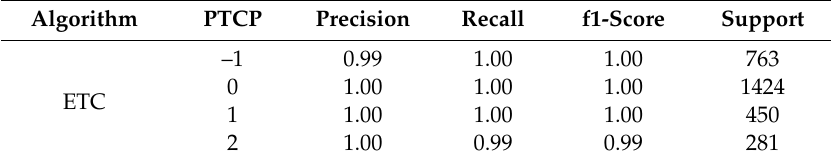
Table 7. Recursive Feature Elimination for R scenario.